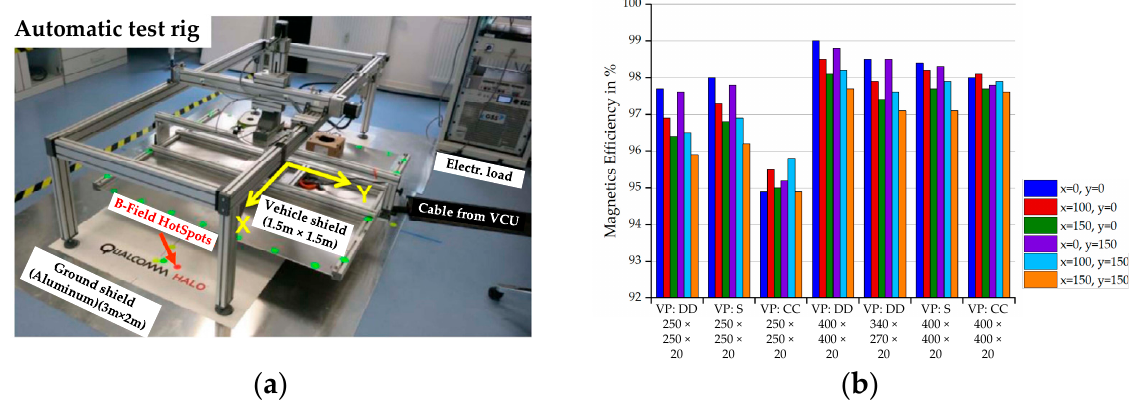
Figure 8. Interoperability testing by Qualcomm based on the power-efficiency method ( a ) Multi- dimensional movable bench; ( b ) System efficiency test results.